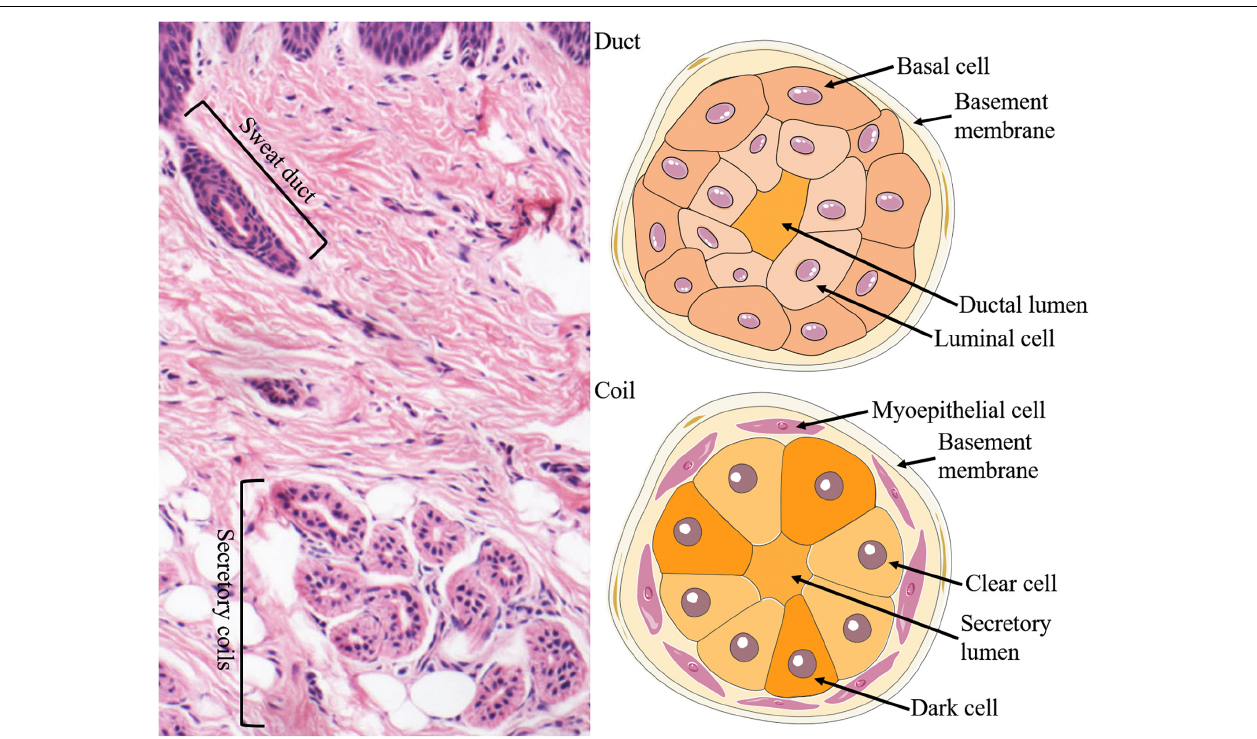
FIGURE 1 | Structure and cellular constituents of ESGs. The ESG is comprised of a relatively straight duct led to the skin surface and a secretory coil deep in the dermis (left panel). The duct is formed of two layers of cells: the basal (outer) and luminal (inner) cells, where ions are partially reabsorbed (right upper panel). There are three types of cells in the secretory coil: clear cells, dark cells, and myoepithelial cells (right lower panel).